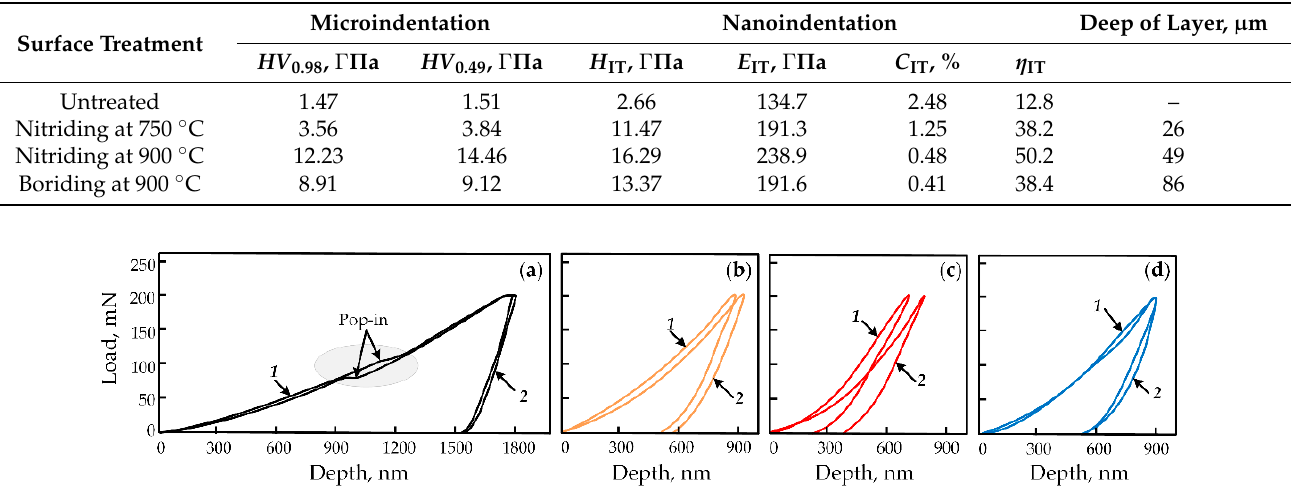
Figure 10. Loading and unloading curves of titanium Grade 2 during nanoindentation in initial state ( a ) and after nitriding at 750 °C ( b ) and 900 °C ( c ) and after boriding ( d ): 1 and 2—nanoindentation near grain boundary and in grain body, respectively.